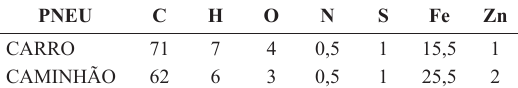
Table 4. Typical tire chemical composition in % mass 5 .